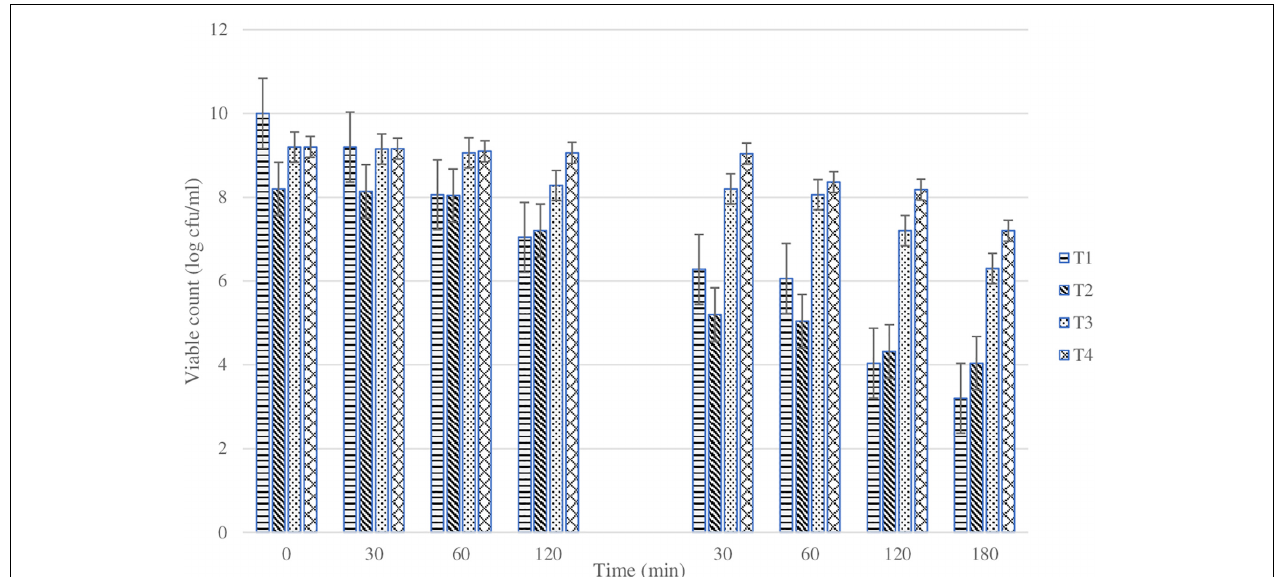
FIGURE 8 | Changes in viability (cell count) of plain or coated L. rhamnosus cells after exposure to sequential gastric conditions for 30, 60, and 120 min. Tl: plain L. rhamnosus, T2: coated cells with BSP/Glucomannan, T3: coated cells with BSP/Alginate and T4:coated cells with BSP/Inulin.